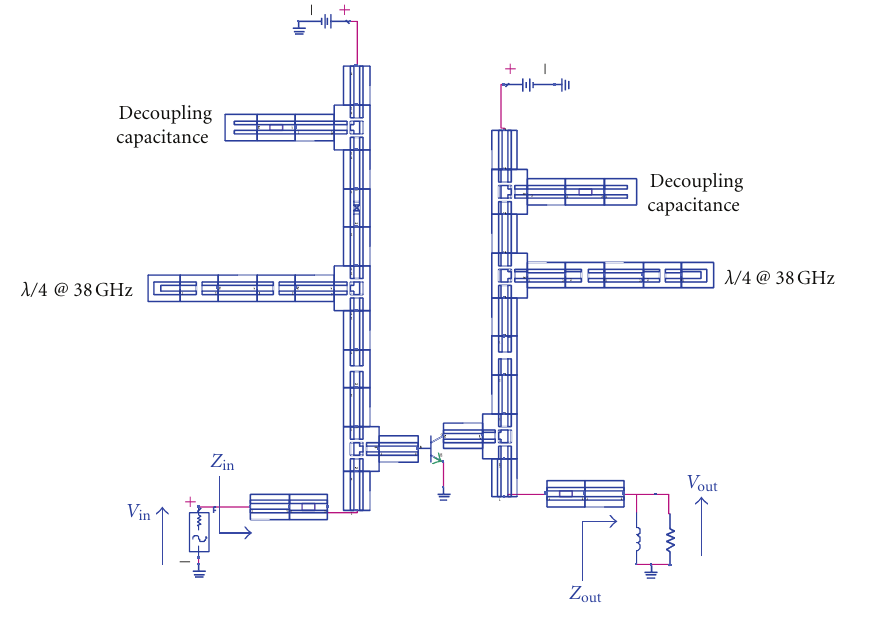
Figure 11: Circuit for nonlinear amplifier simulation.